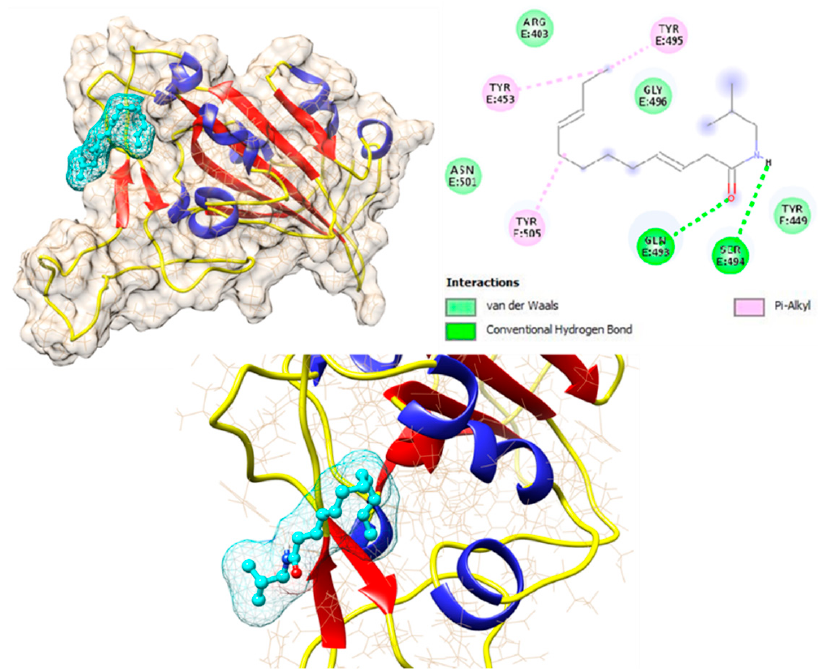
Figure 5. Interaction of dodeca-2E,4E,8Z,10E-tetraensaure-isobutylamid with wild type Spike protein of SARS-CoV-2 protein.